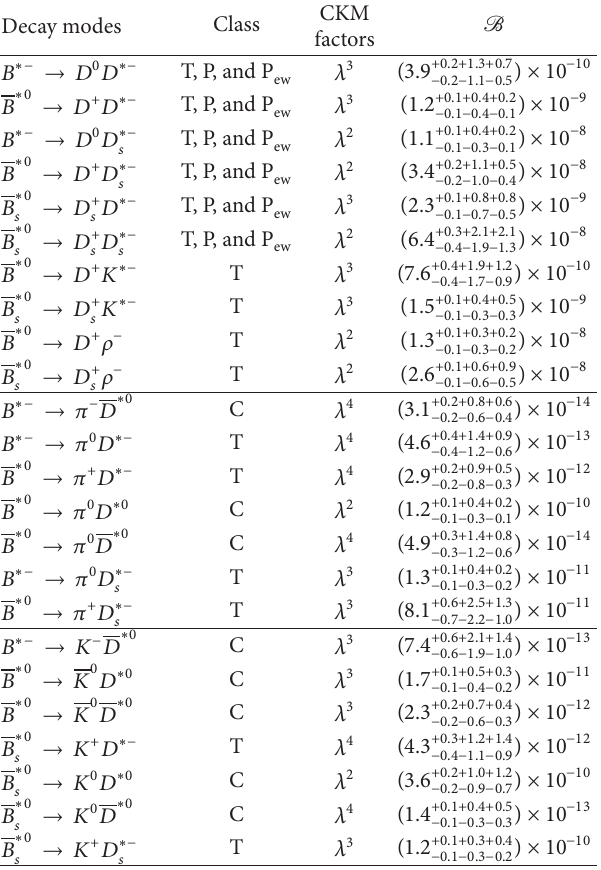
Table 3: The polarization fractions 𝑓 𝐿 and 𝑓 ‖ (in the units of percent). Decay modes 𝑓 𝐿 𝑓